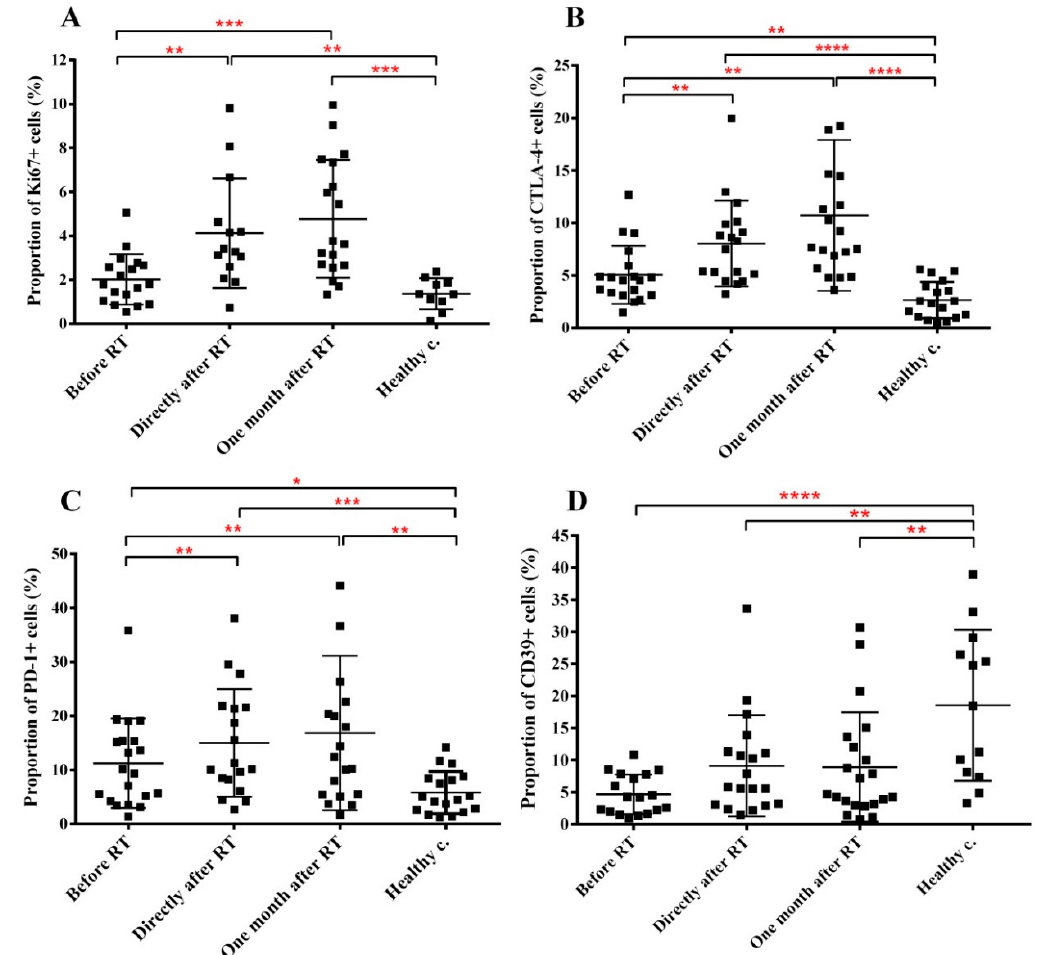
Figure 4. Tumorous condition and RT alters the proliferation and functional integrity of CD4 + cells. PBMCs were isolated from RT-treated H&N cancer patients, processed and labelled with the corresponding antibodies as described in Materials and methods. ( A ) fraction of Ki67 + CD4 cells within the CD4 cell pool. ( B ) fraction of CTLA4 expressing CD4 cells within the CD4 cell pool. ( C ) fraction of PD-1 expressing e ff ector CD4 cells within the total e ff ector CD4 cell population. ( D ) fraction of CD39 + Treg cells within the total Treg population. Student’s paired t -test was used to test significant di ff erences among the three time points of cancer patients’ samples, while unpaired t -test was used to test significant di ff erences between the three time points and healthy control group using 95% confidence interval. Data are shown as individual data points together with the mean ± SD (cancer patients n = 23, healthy controls n = 15). Significant di ff erences were indicated with * ( p < 0.05), ** ( p < 0.01), *** ( p < 0.001) and **** ( p <